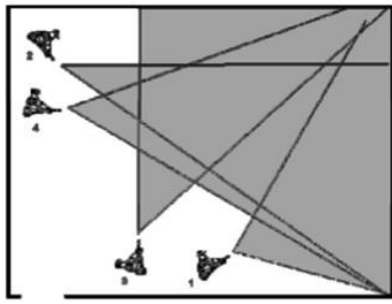
Figure 1. Final position of fire team for corner entry room (US Army, 2002, [183]).